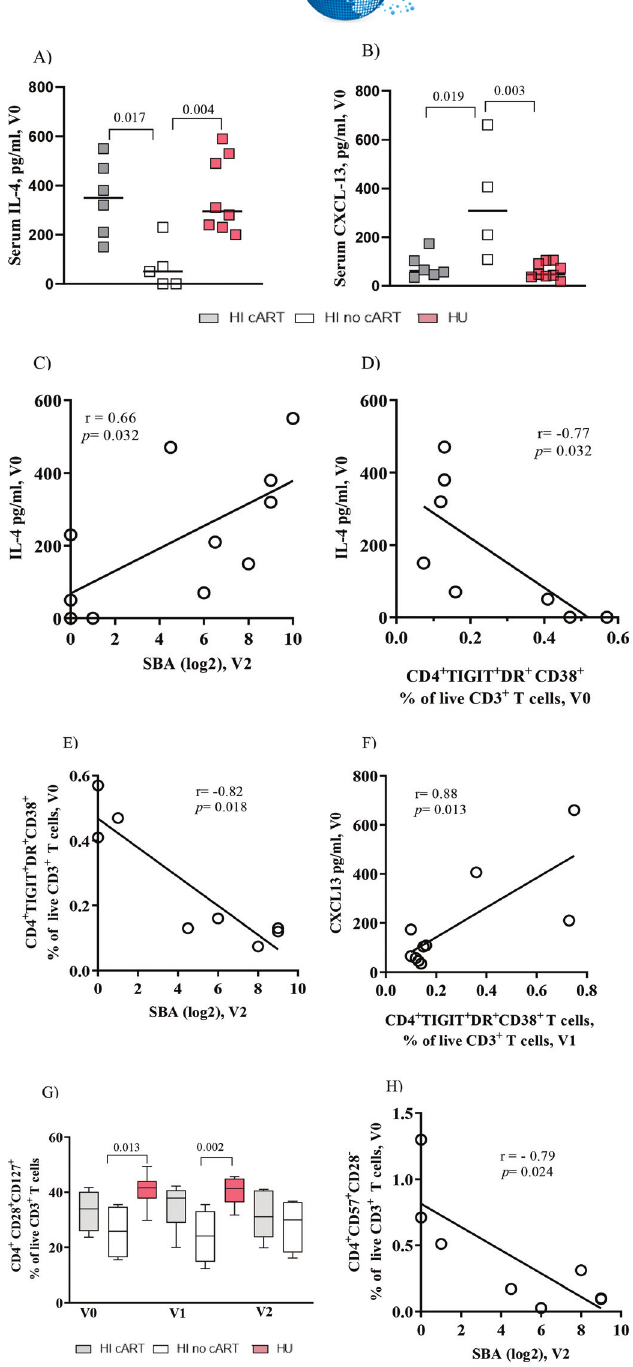
Figure 2 - Baseline serum levels of IL-4 are positively correlated with vaccine-elicited bactericidal antibody titers in HI patients. IL-4 and CXCL-13 levels show opposite correlations with the frequency of exhausted CD4 + T cells. (A) Pooled data show that the serum IL-4 levels in the HI /cART group (gray closed squares) are significantly higher than those in the HI/no-cART (opened squares) group but are similar to those detected in the HU cohort (red closed squares). (B) The HI/no-cART group (opened squares) shows increased levels of baseline CXCL-13 than the HI/cART group (gray) and HU cohort (red). (C) Baseline blood IL-4 levels of the HI cohort (cART and no-cART) are positively correlated with the SBA at V2 but (D) negatively associated with TIGIT + DR + CD38 + CD4 + Tcells at V0. (E) In the HI cohort, a negative association between the frequency of CD4 + T cells expressing TIGIT/DR/CD38 at V0 with SBA at V2 can be seen simultaneously with (F) a positive correlation of TIGIT + DR + CD38 + CD4 + T cells at V1 with the CXCL-13 levels at V0. (G) The HI/no-cART group shows a significant reduction of the frequency of CD4 + Tcells expressing CD28 and CD127 compared with the HU cohort. (H) The lack of CD28 expression together with CD57 expression (V0) negatively associates with SBA at V2 for HI cohort. p -values were calculated using the Mann-Whitney test. Spearman non-parametric test was used for correlation analyses. Statistical significance was set at p o 0.05.